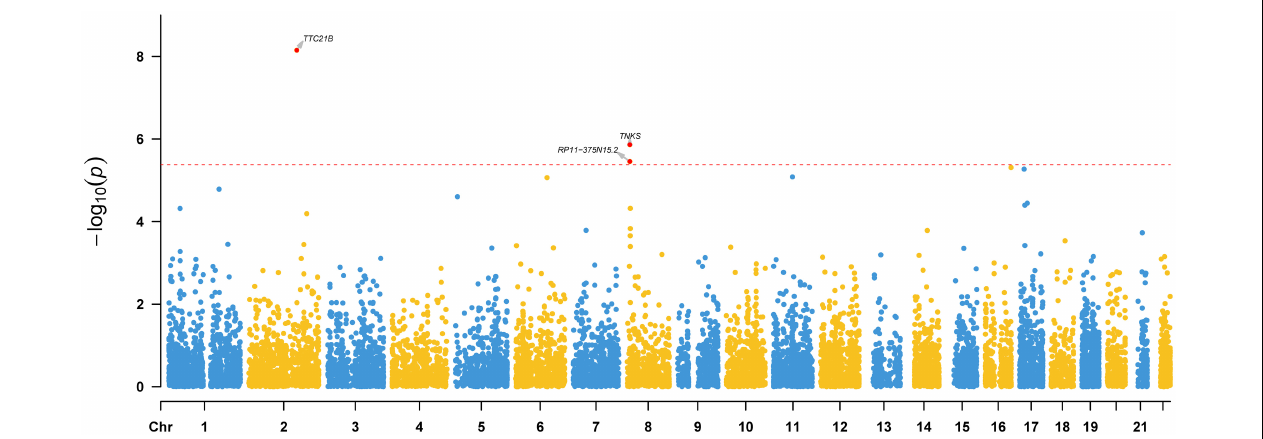
FIGURE 4 | Transcriptome-wide association study (TWAS) results of epilepsy. Three genes ( TTC21B, RP11-375N15.2 , and TNKS ) showed transcriptome-wide significant (TWS) associations with epilepsy, indicating that the genetically regulated expression of these genes are associated with epilepsy. Transcriptome-wide significance (corrected by Bonferroni adjustment) is marked by a red dotted